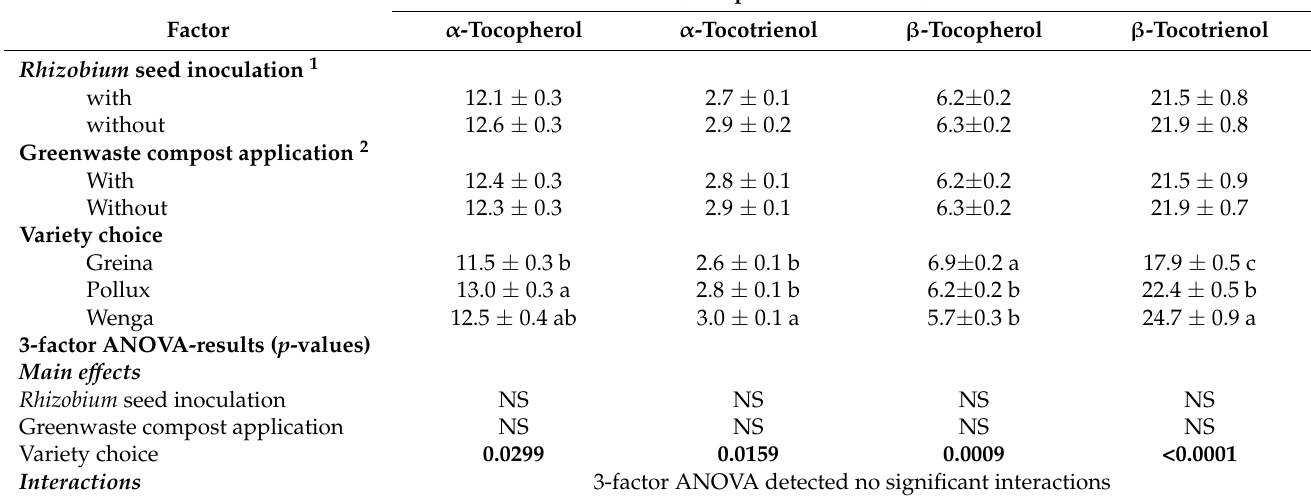
Table 8. Effect of clover ley management ( Rhizobium inoculation of clover seed and greenwaste compost applications) on Vitamin E (tocopherol and tocotrienol isomers) concentrations ( µ g/g) in grain from contrasting winter wheat varieties established after two-year clover leys. Values shown are main effect means ±